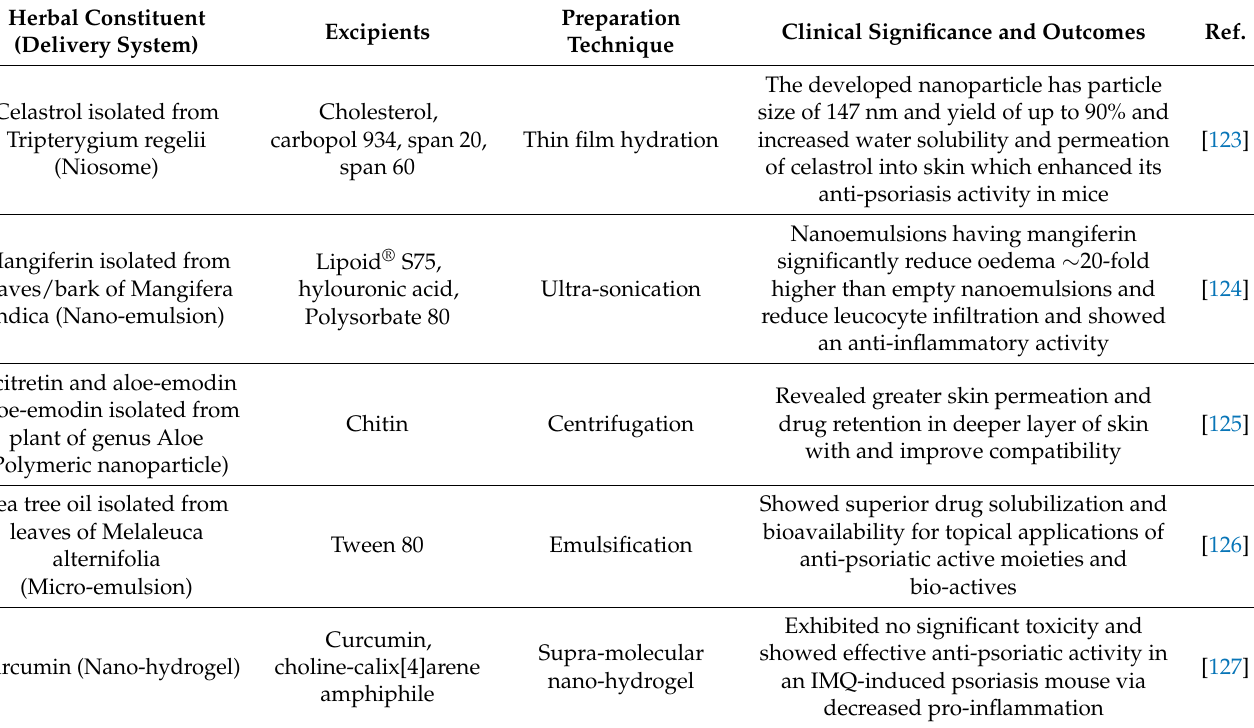
Table 8. Recent works in herbal colloidal drug delivery systems for psoriasis